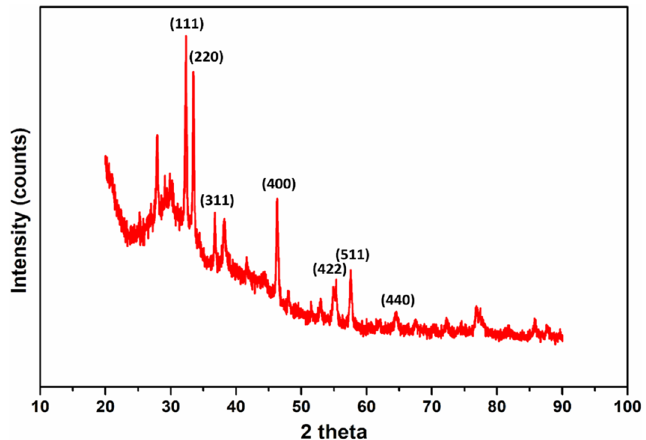
Figure 8. XRD pattern of the biosynthesized Fe 3 O 4